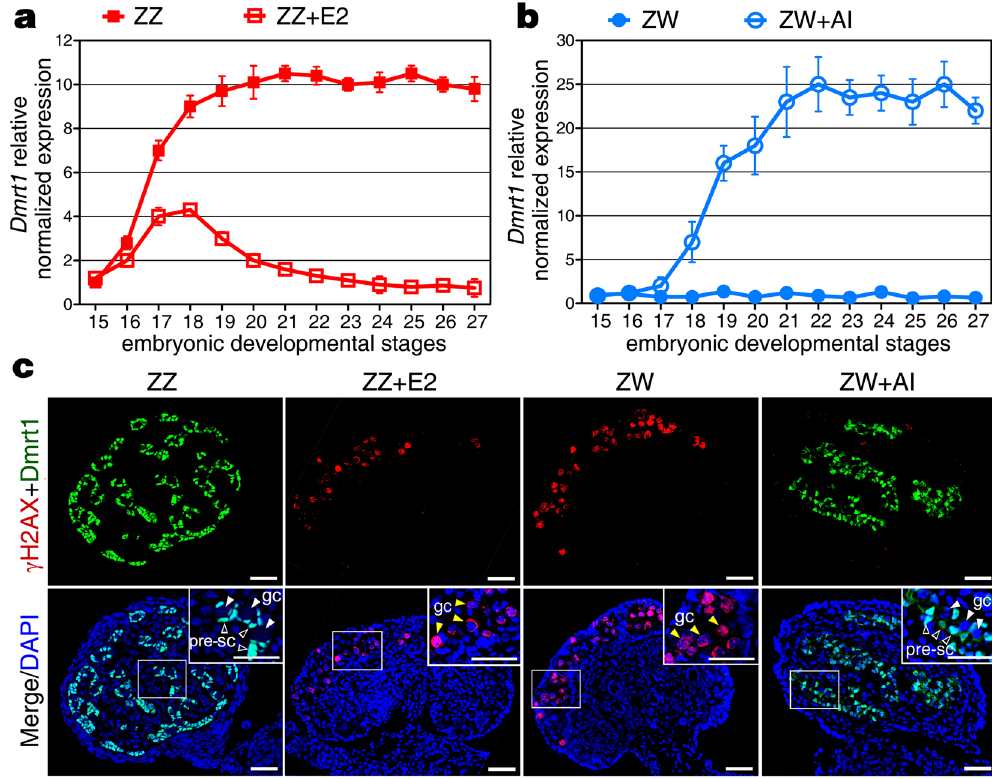
Figure 3. Upregulation of Dmrt1 in ZW embryonic gonads during female to male sex reversal. ( a ) qRT-PCR analysis showed that Dmrt1 mRNA expression exhibited a dramatic down-regulation in E 2 -treated ZZ gonads from stage 17 to 27, compared to the control ZZ gonads. Data are shown as means ± S.D. N ≥ 3. ( b ) In AI- treated ZW gonads, Dmrt1 expression was induced from stage 18, reached the peak at stage 22, and maintained at high level since that time. Data are shown as means ± S.D. N ≥ 3. ( c ) Double immunofluorescence of Dmrt1 and γ H2AX was performed in sections of the control ZZ gonads, E 2 -treated ZZ gonads, the control ZW gonads and AI-treated ZW gonads at stage 27. In AI-treated ZW embryonic gonads, Dmrt1 protein expression was strikingly up-regulated in medulla, as well as γ H2AX protein expression almost disappeared. pre-sc, precursor sertoli cell; pgc, primordial germ cells. Scale bars are 50 μ